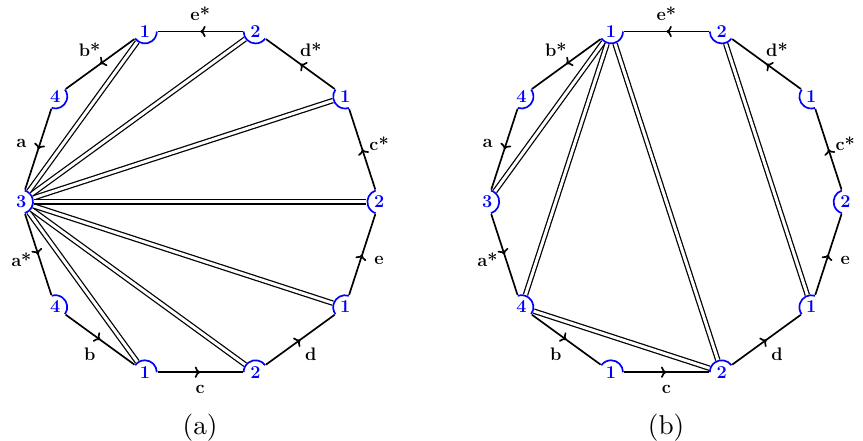
Figure 14 . Genus One: A maximal skeleton graph with only triangular faces (a), and an edge- saturated skeleton graph with triangular and square faces